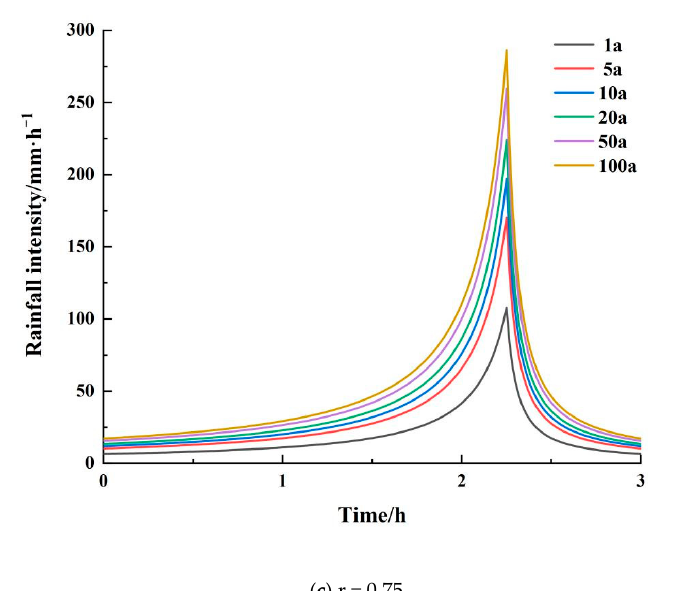
Figure 3. Chicago rain pattern.